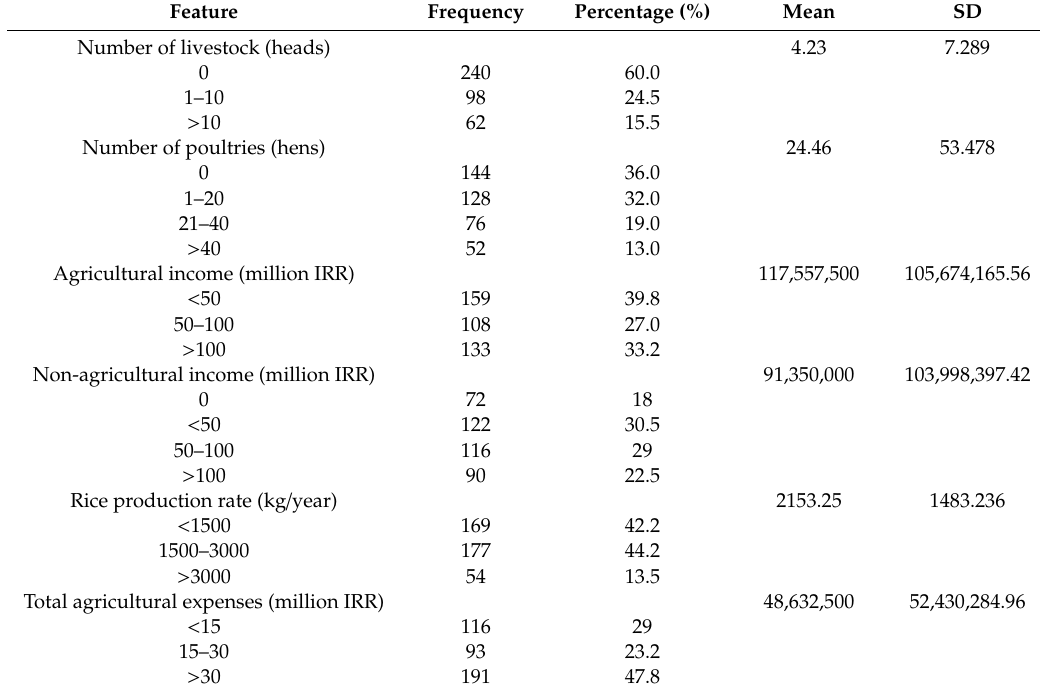
Table 2. Economic aspects of rice growers in Rudsar County ( n = 400).